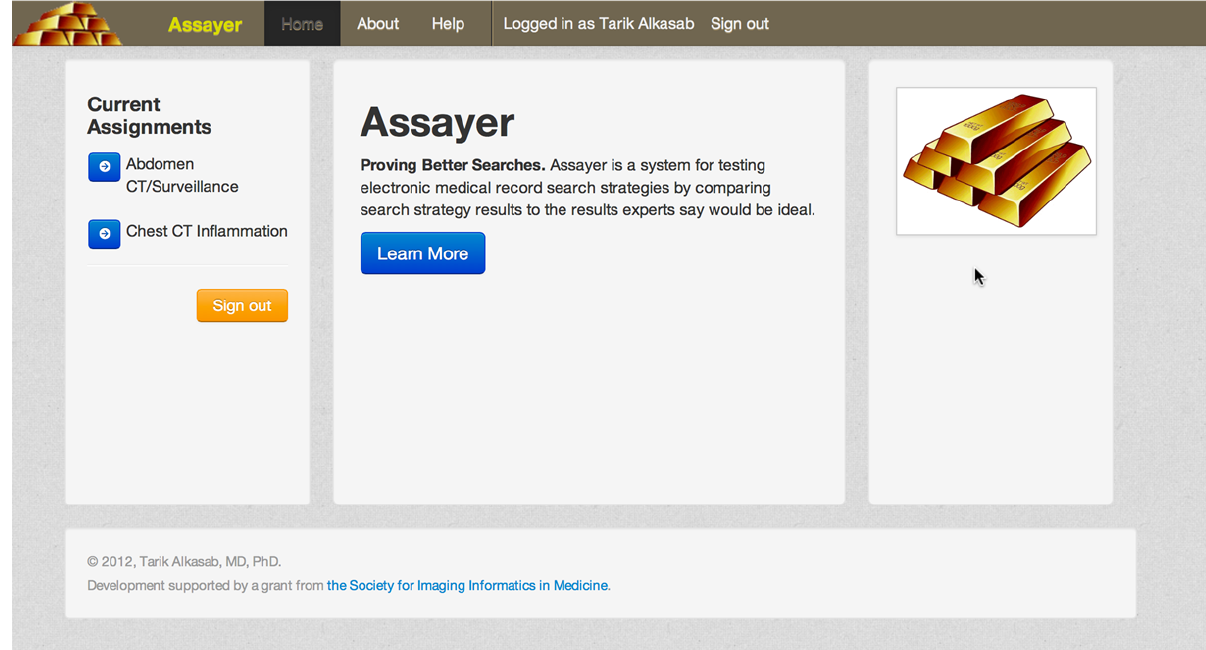
Figure 2. Post log-in page showing assigned tasks. After a user logs into the system, they are presented with a list of their currently assigned clinical scenarios. They can use these links to move directly to the rating